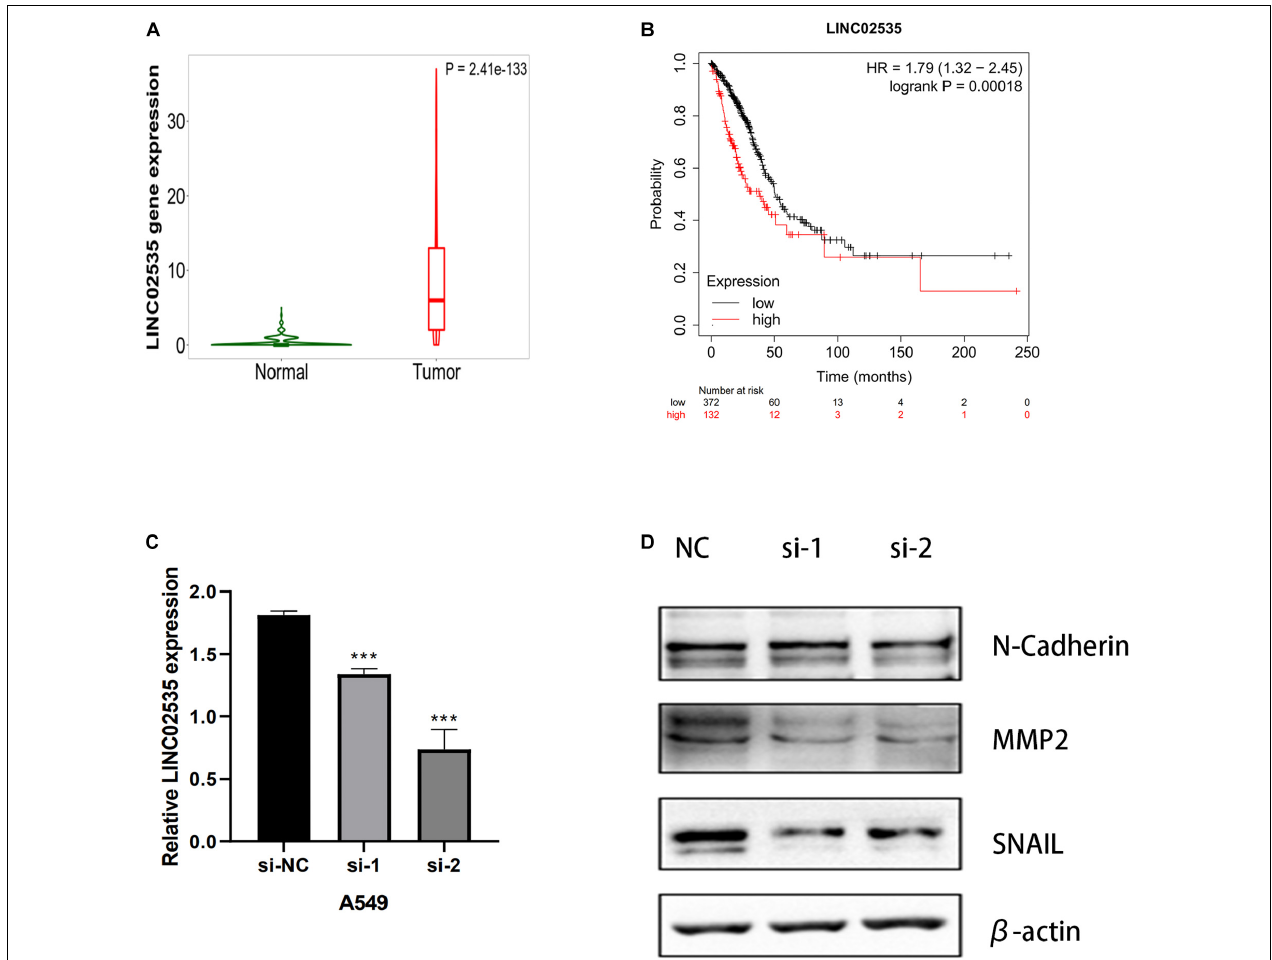
FIGURE 10 | LINC02535 enhances the invasion and migration of LUAD cell in vitro . (A) The expression of LINC02535 in samples. (B) The survival analysis of LINC02535. (C) Quantitative real-time PCR analysis of LINC02535 expression in LINC02535-silenced cell and scrambled-siRNA-treated cell. (D) The protein levels of N-cadherin (CDH2, MMP2, and SNAIL were detected by Western blotting in the LINC02535-knockdown group. *** P <